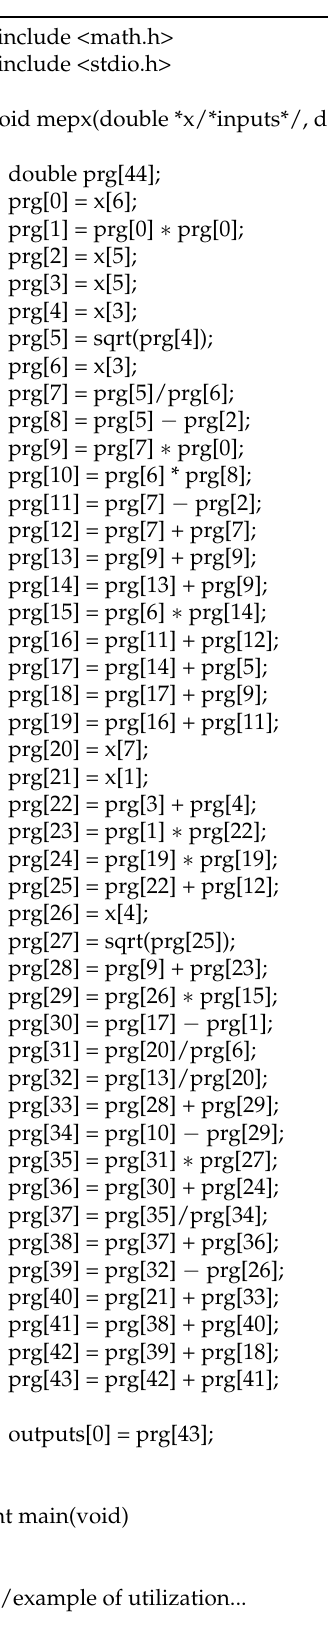
Table A2. A-2: MEP generated code for prediction of Total Dissolved Solid